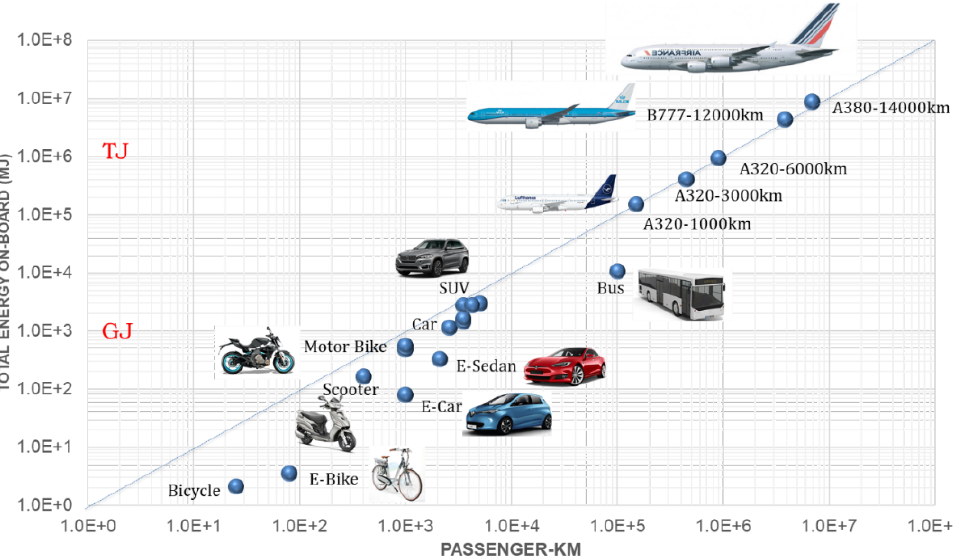
Figure 6. Typical values of the total energy carried on-board for different types of passenger vehicles.